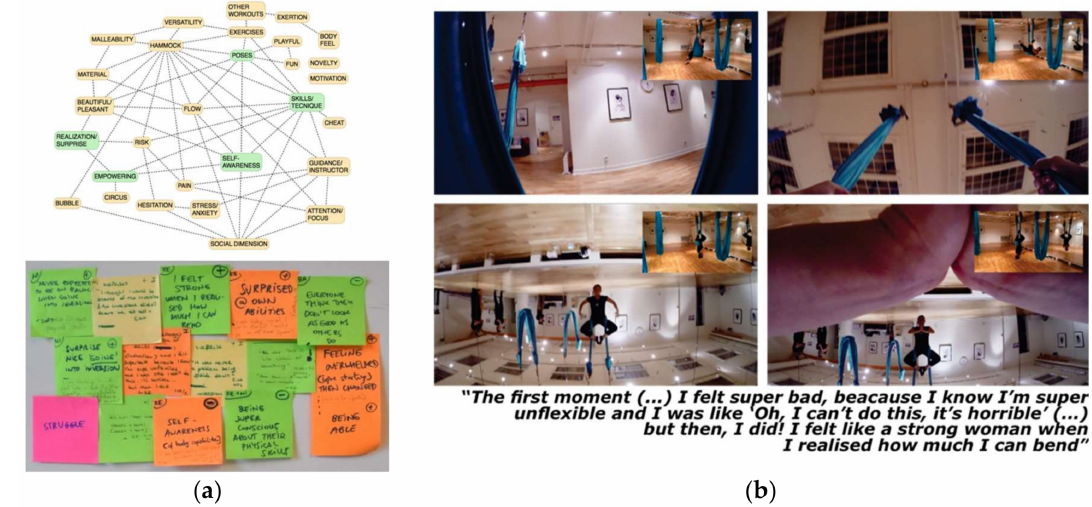
Figure 16. Empowering Situations . (a) The corresponding analysis’ categories, with the ones that the SomaBoard relate to ( realization/surprise, empowering, self-awareness, poses and skills/technique ) highlighted, and a picture of the original post-its. ( b ) SomaBoard depicting four screenshots of a video (included as Supplementary Materials) showing an inversion from a first and third person